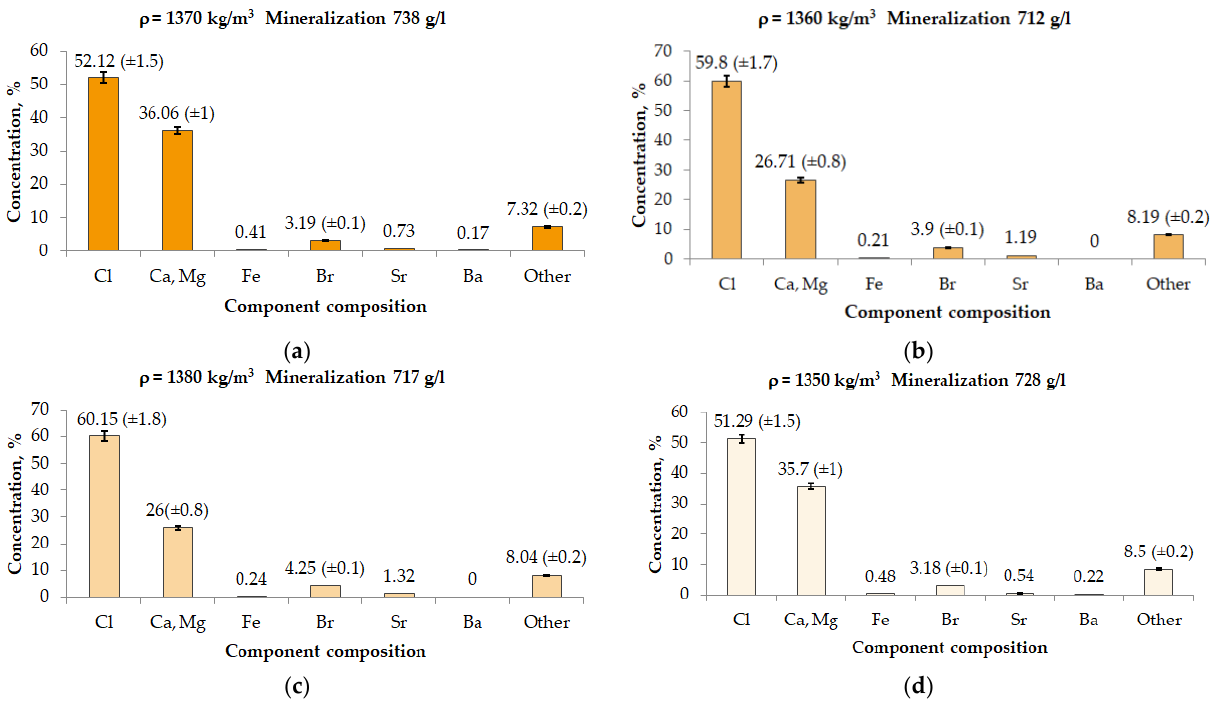
Figure 2. Analysis of the dry residue of formation fluid using the calibration graph method. ( a ) Sample No. 1, bottom hole 2153 m (after a day of overflow); ( b ) Sample No. 2, bottom hole 2236 m; ( c ) Sample No. 3, bottom hole 2236 m; and ( d ) Sample No. 4, bottom hole 2153 m (bottom hole pack).